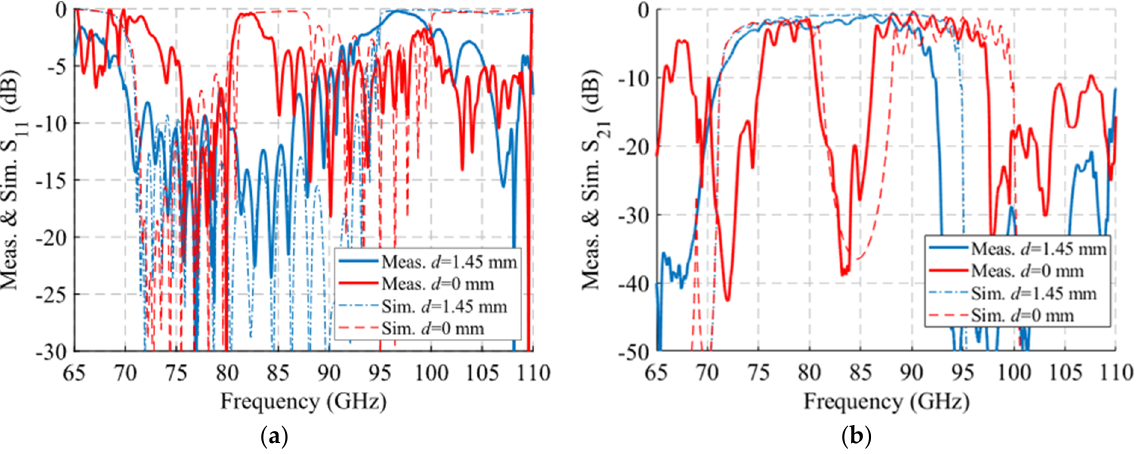
Figure 36. Comparison of the measured and simulated S-parameters of the single-periodic proto- type for glide symmetric configuration ( d = 1.45 mm) and maximum brake of the symmetry ( d = 0 mm). ( a ) S 11 and ( b ) S 21 parameters.